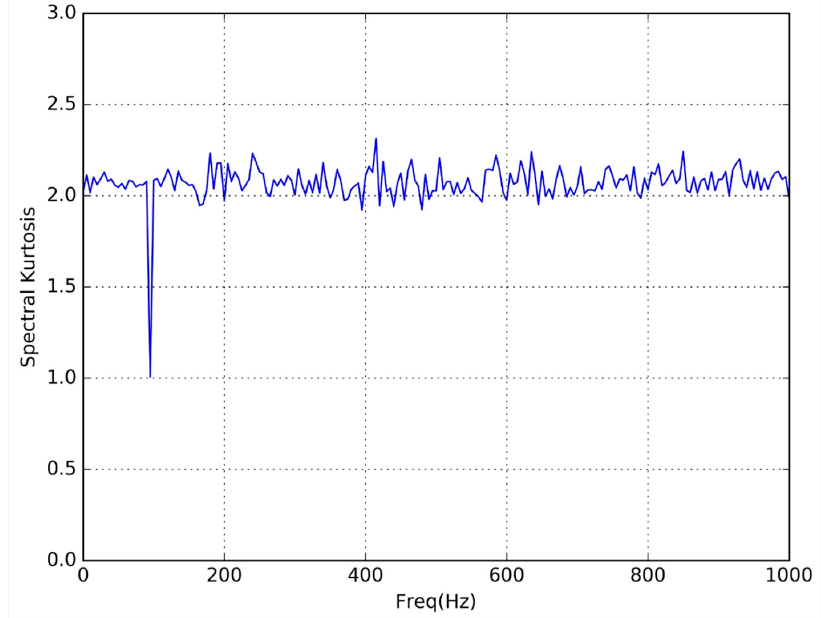
Figure 3. Spectral kurtosis (SK) from experiment FPGA 1. Sine wave signal, 100 Hz.